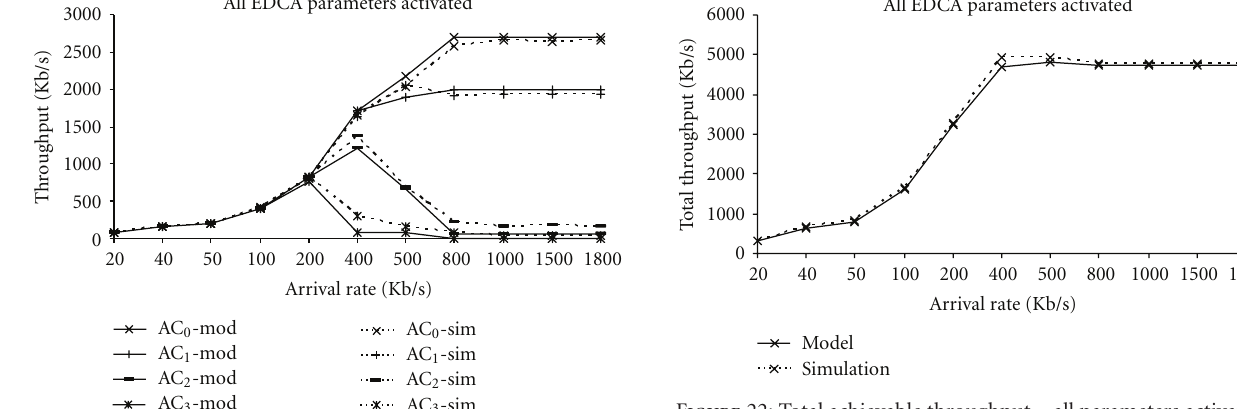
Figure 22: Total achievable throughput—all parameters activated.